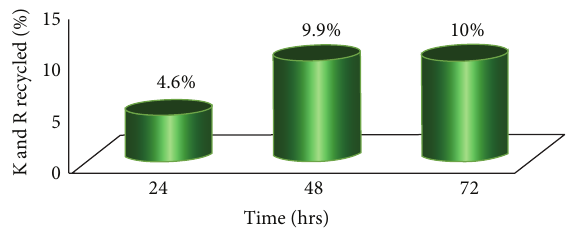
Figure 3: Lysine and arginine recycling in WT EGFR in A431 cells. K and R recycling was calculated by quantifying EGFR peptides with a single missed cleavage from two separate sets of cells, each sample analyzed twice for a total of four MS analyses. The amounts of HH (new peptide), HL (new peptide with recycled amino acid), and LL (old peptide or both amino acids’ recycled peptide) were measured. LL was assumed to be composed of only original peptides for this calculation. Recycling appeared to plateau at or before 48 hours which was not unexpected.